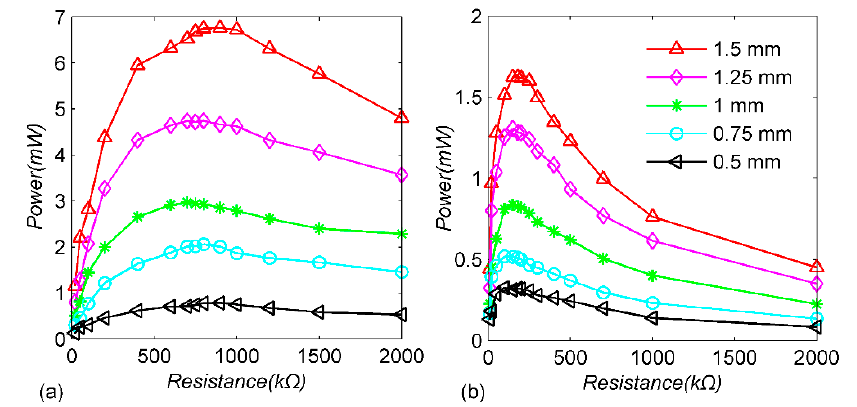
Figure 9. Experimental harvested power for different amplitudes and load values in the constant- excitation-frequency case: ( a ) SSHI-PBMS circuit; ( b ) standard circuit.